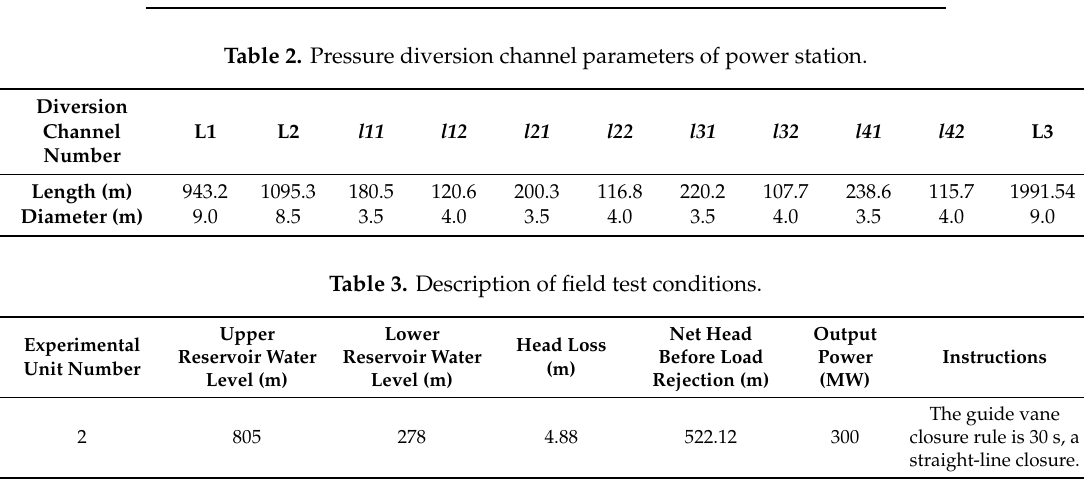
Table 3. Description of field test conditions.